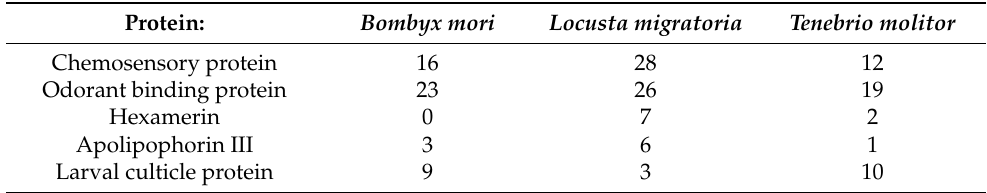
Table 4. Number of specific protein isoforms identified in Bombyx mor i, Locusta migratoria , and Tenebrio molitor , from the genome assemblies available at the NCBI database.